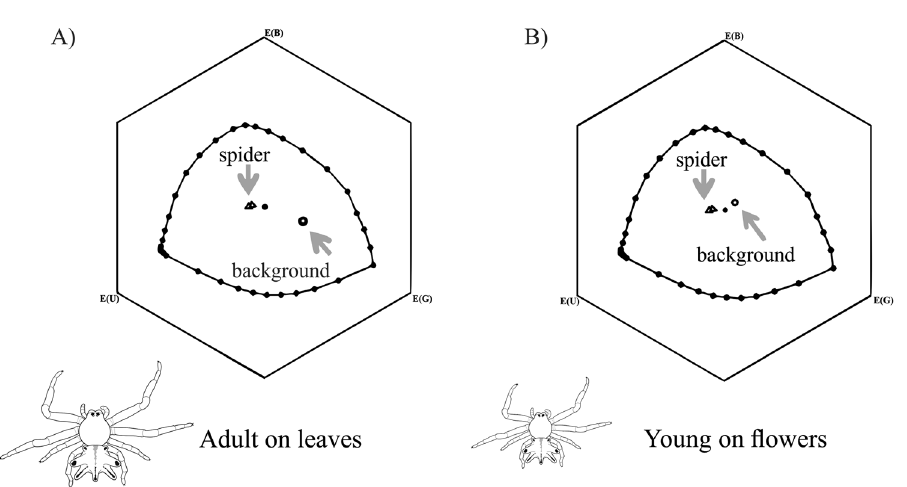
Figure 3. Photoreceptor stimulus representation in the visual system of bees. ( A ) Adult Epicadus heterogaste r on Miconia sp. (Melastomataceae) leaves. ( B ) Young Epicadus heterogaster upon flowers (credit to the spiders drawing: Soleman,